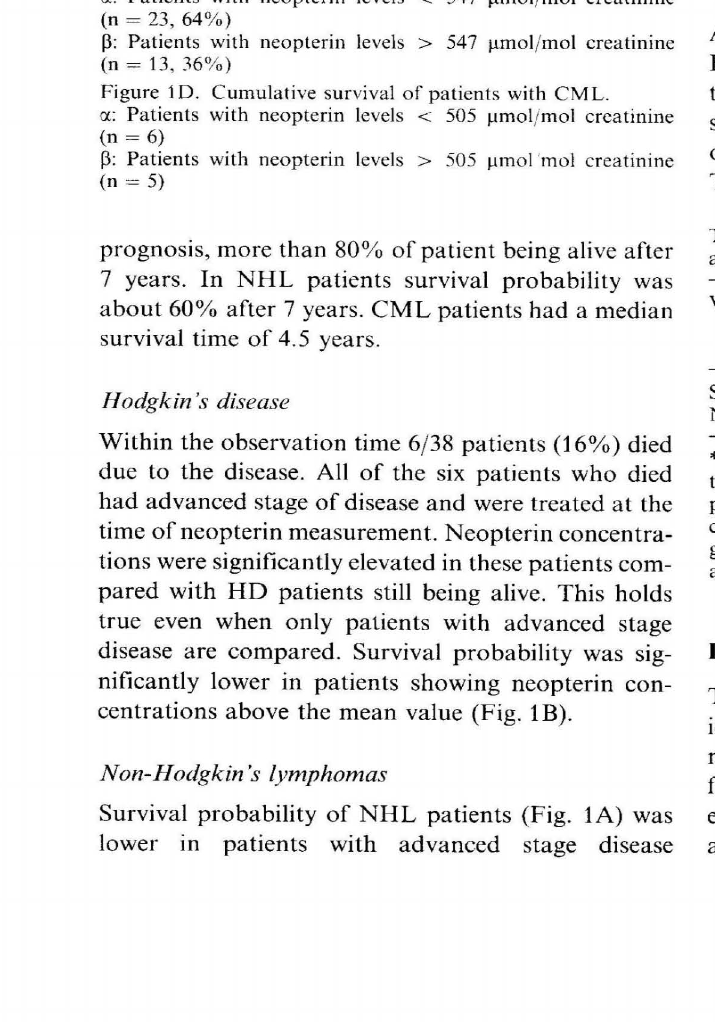
Table 2. Multivariate analysis of sun'ival using tumour stage and neopterin as